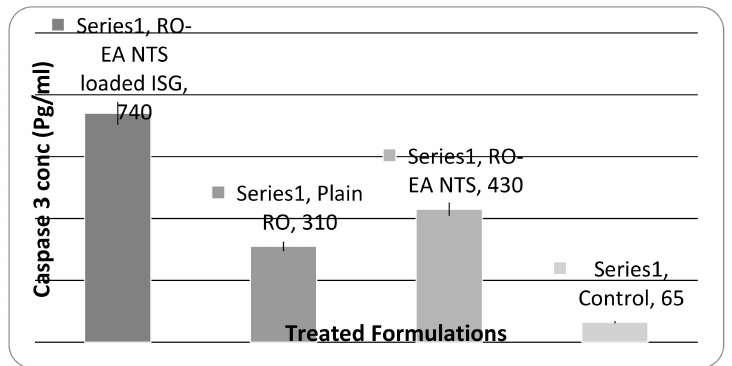
Figure 10. Caspase-3 enzyme concentrations in human chondrosarcome-3 cells treated with di ff erent formulations, and control (solvent-free); data are presented as the mean ± SD. ( n =